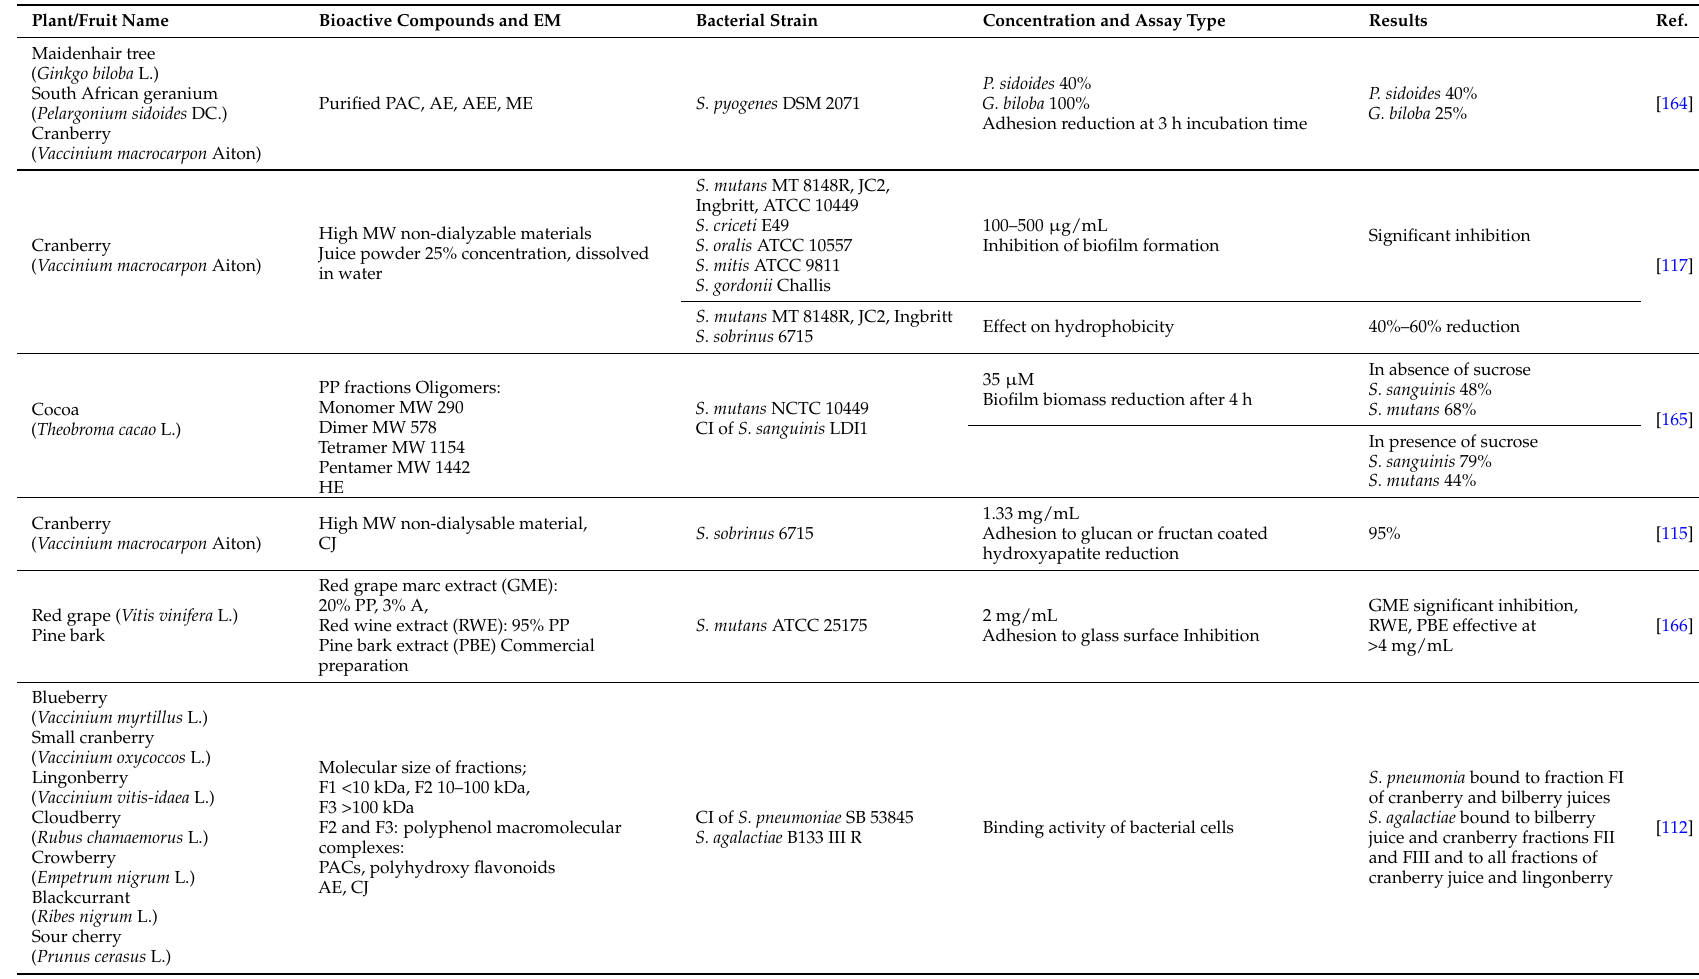
Table 4. Inhibitory effects of phytochemicals against adhesion, biofilm formation and